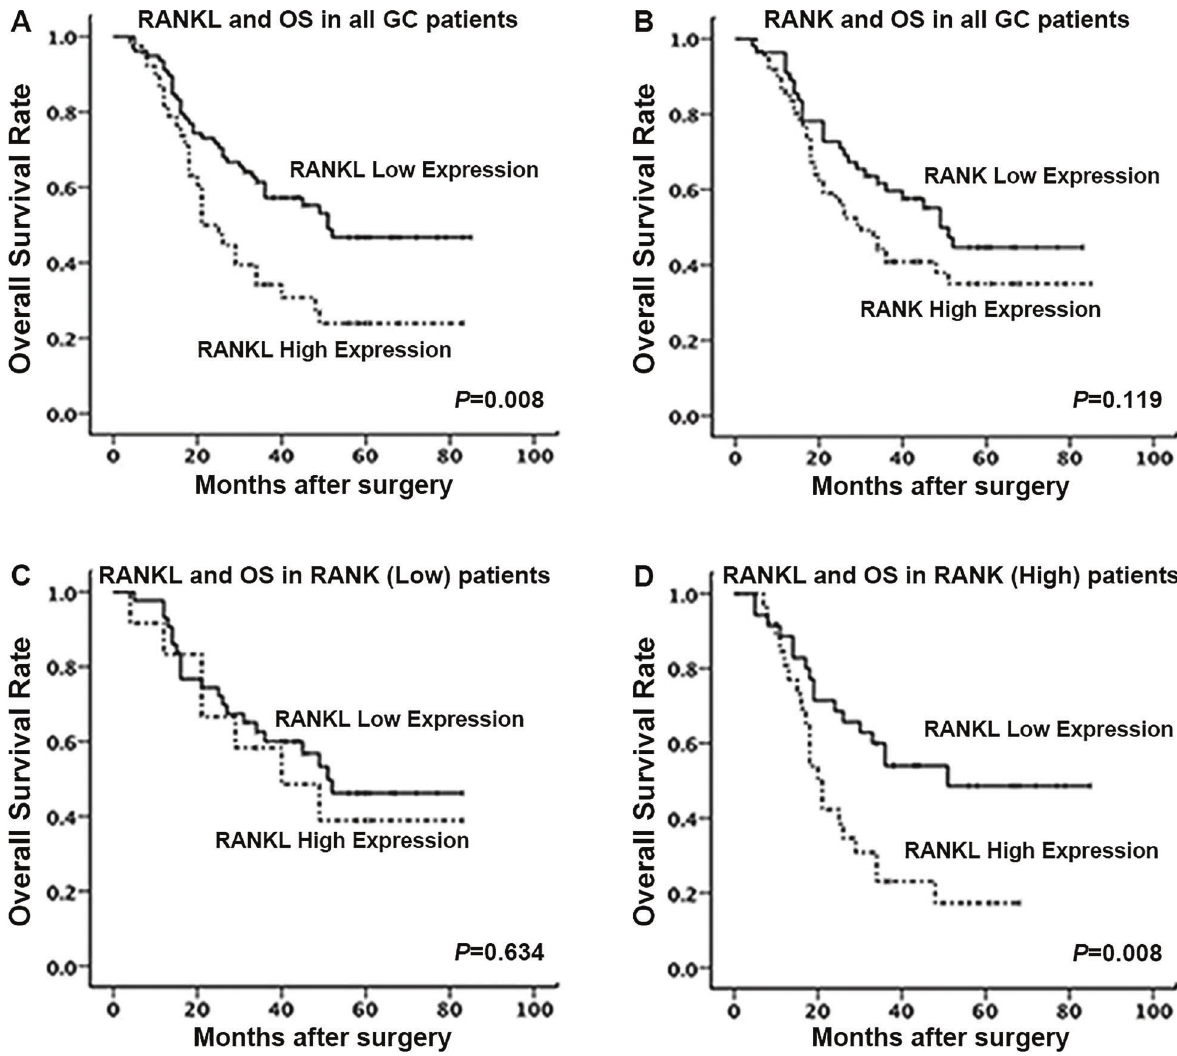
Figure 2. Prognostic signi fi cance of RANKL and RANK expression in gastric cancer (GC) patients. Kaplan-Meier analysis of overall survival (OS) for RANKL ( A ) and RANK ( B ) expression in all gastric cancer patients. Strati fi cation analysis for the RANKL expression in low ( C ) and high ( D ) RANK expression